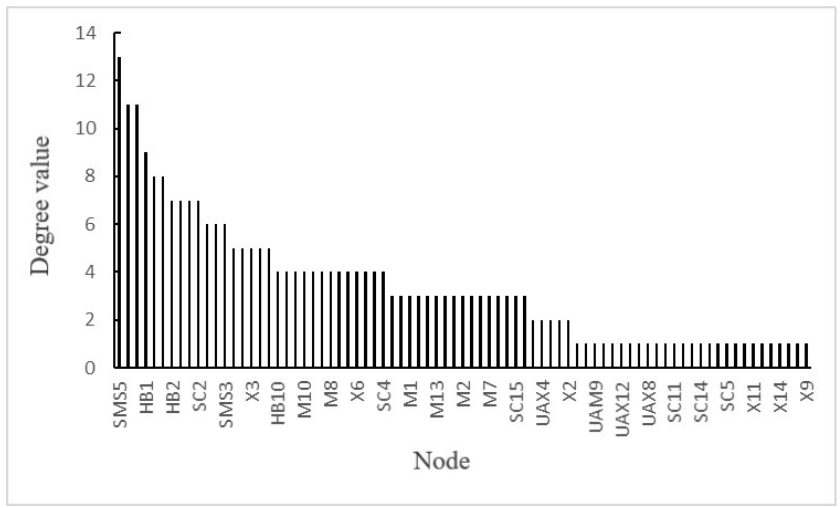
Figure 10. Degree values of each node in causation network of accident.